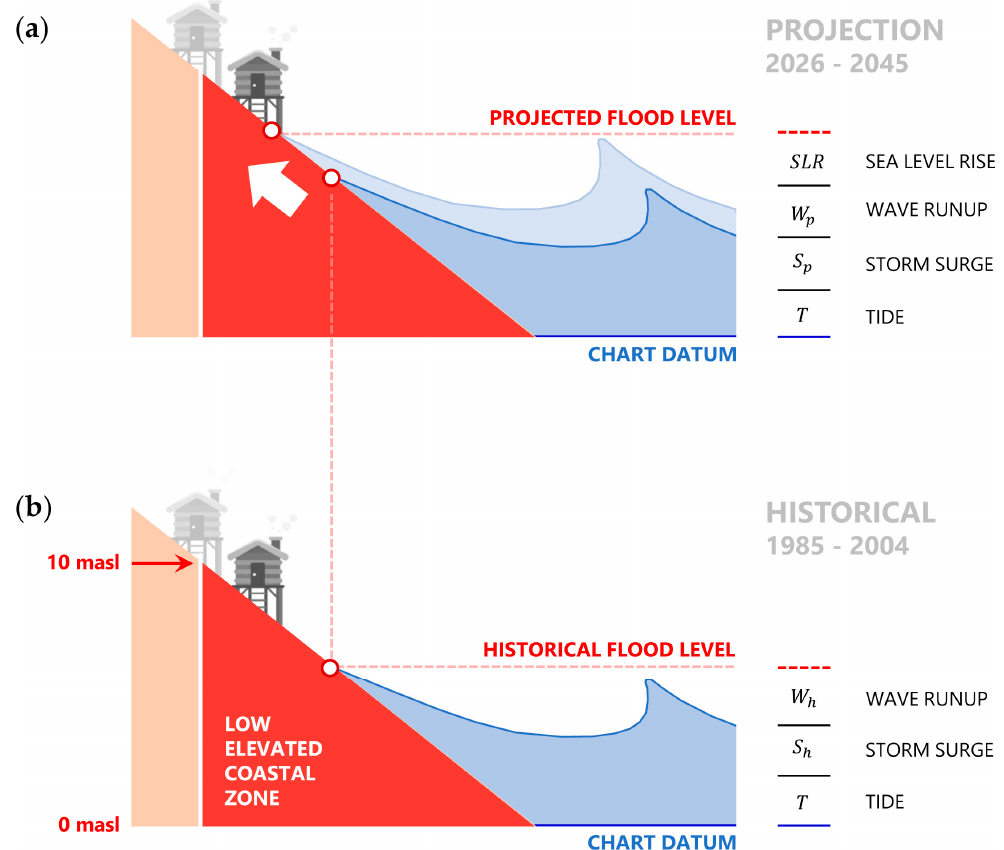
Figure 2. Conceptual model for the exposure and flood hazard used to compute the risk in coastal settlements. ( a ) Projected flood level (2026–2045) with respect to the historical chart datum used as a reference level. ( b ) historical flood level (1985–2004). The red arrow shows the upper bound of the low elevated coastal zone.